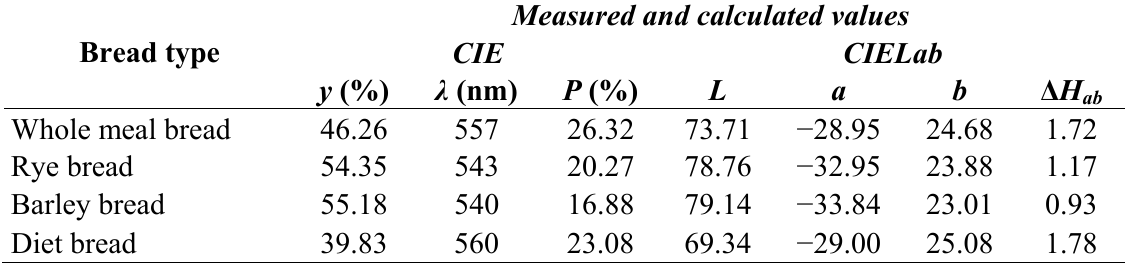
Table 2. Results of instrumental color determination of different kinds of bread after their storaging for 3 days at ambient temperature (20 ± 2